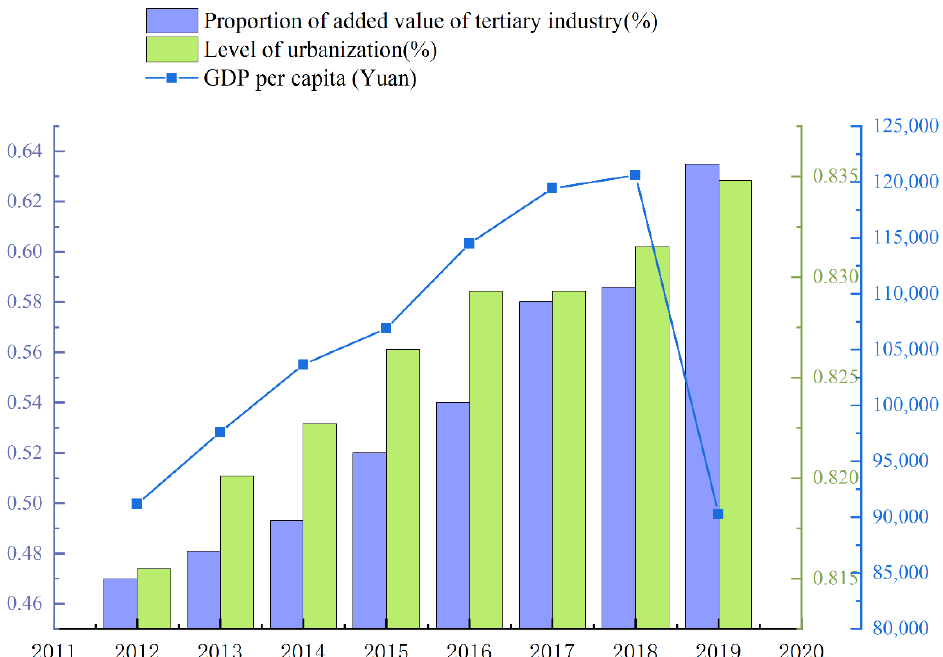
Figure 2. In dex data affecting carbon emission in Beijing.